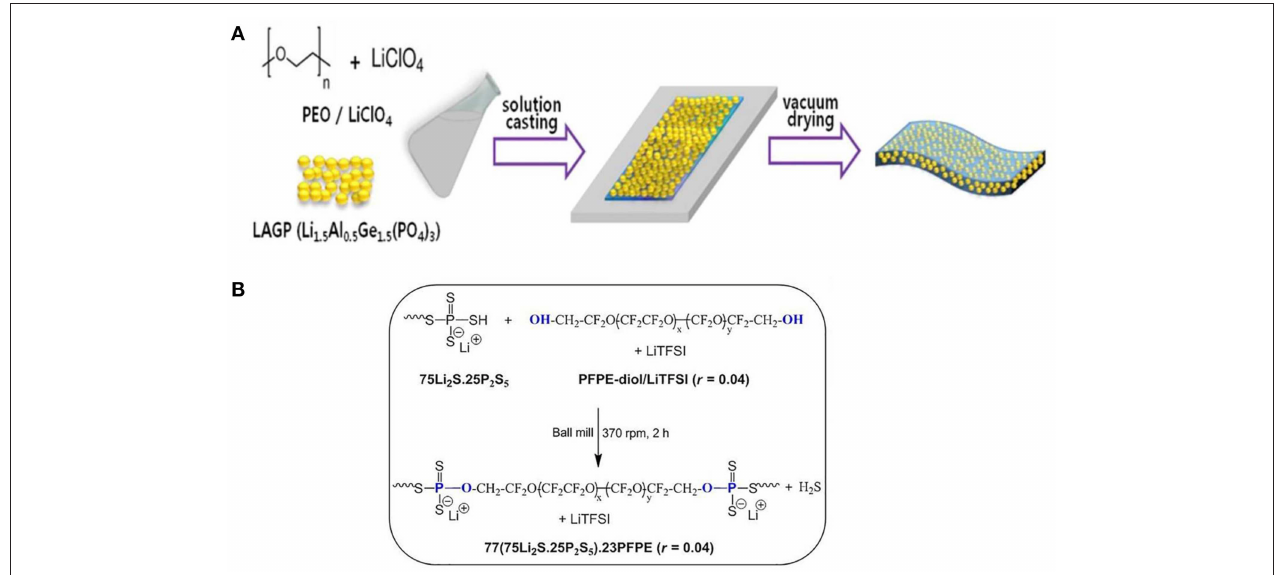
FIGURE 8 | (A) Schematic presentation of preparation for PEO-LiClO4-LAGP hybrid solid electrolyte. [Reproduction with permission from Jung et al. (2015) Copyright 2017, The Electrochemical Society.] (B) Synthesis of the hybrid electrolyte 77(75Li 2 S.25P 2 S 5 ).23PFPE ( r = 0.04) by mechanochemical reaction. [Reproduction with permission from Villaluenga et al. (2016). Copyright 2016, National Academy of